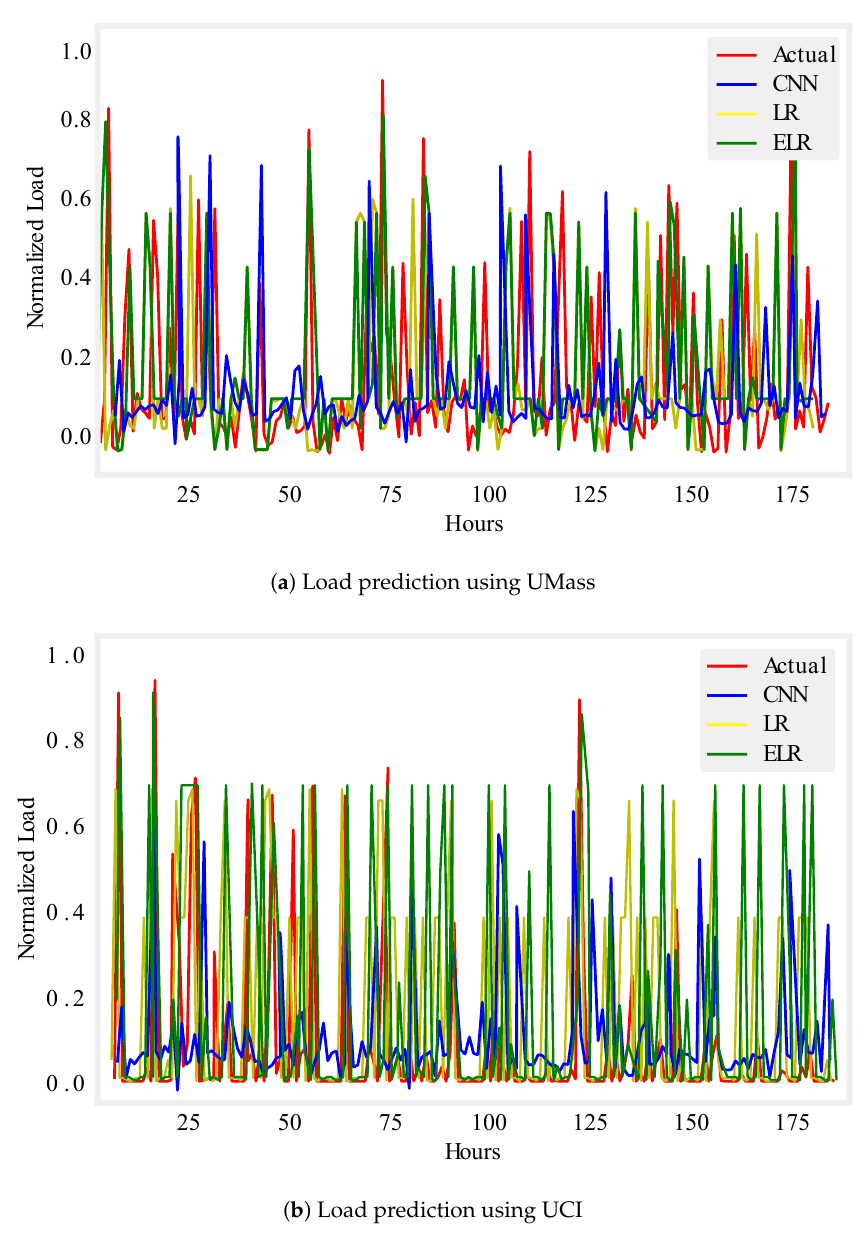
Figure 7. One month load